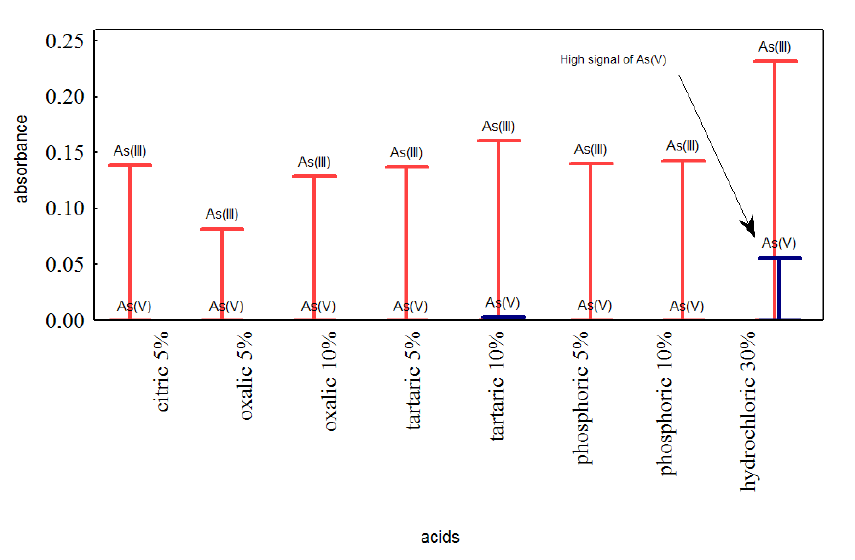
Fig. 3 The analytical system corresponding to As (III) and As (V) in environment of different acids (10